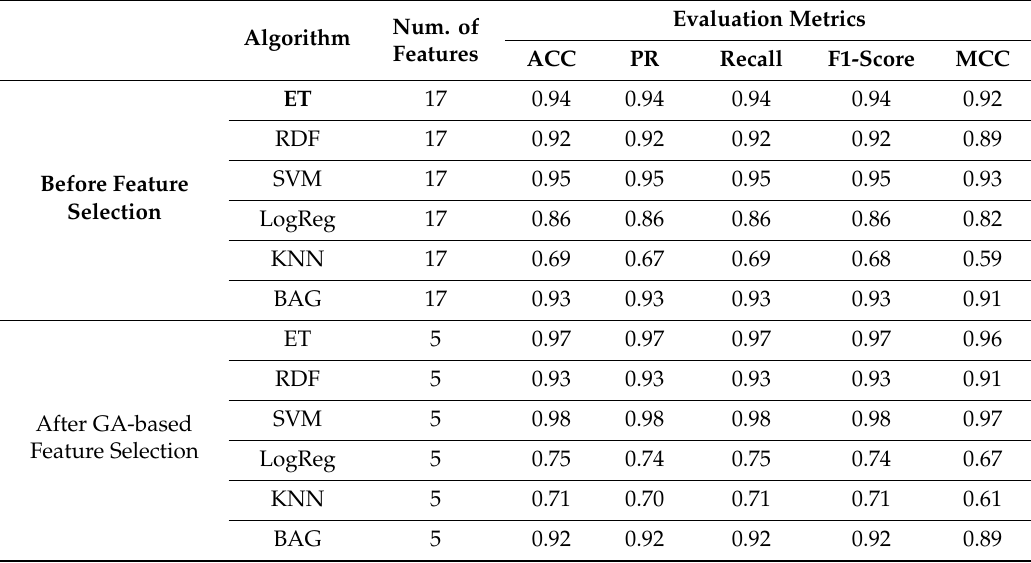
Table 2. Comparison of prediction results of individual machine learning methods on CT scan dataset before and after feature selection (see Appendix A, Table A1 for further details).